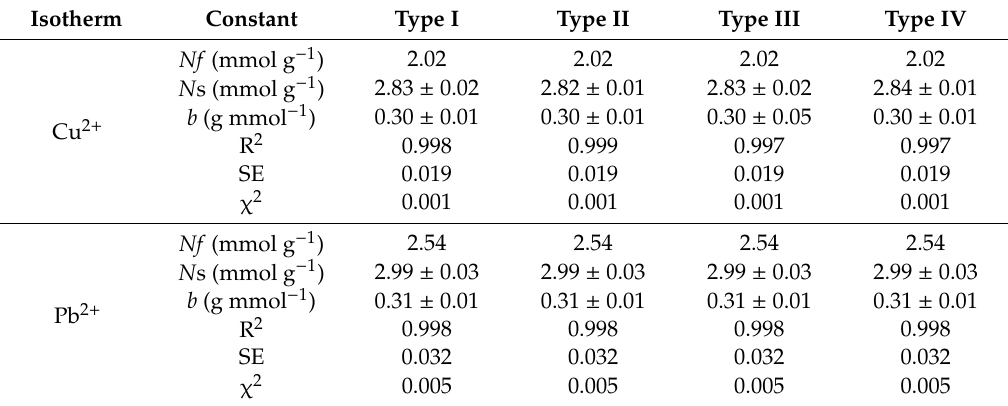
Table 2. Number of moles sorbed ( Nf ), parameters of the Langmuir ( Ns and b ), correlation coe ffi cients (r), and standard errors (SE) for the interaction of divalent metals with modified chitosan CH-AN at 298 ± 1 K using linear